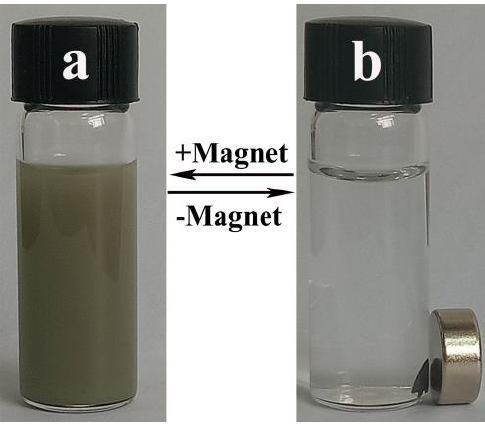
/ Ag / POMs in 3 O 4